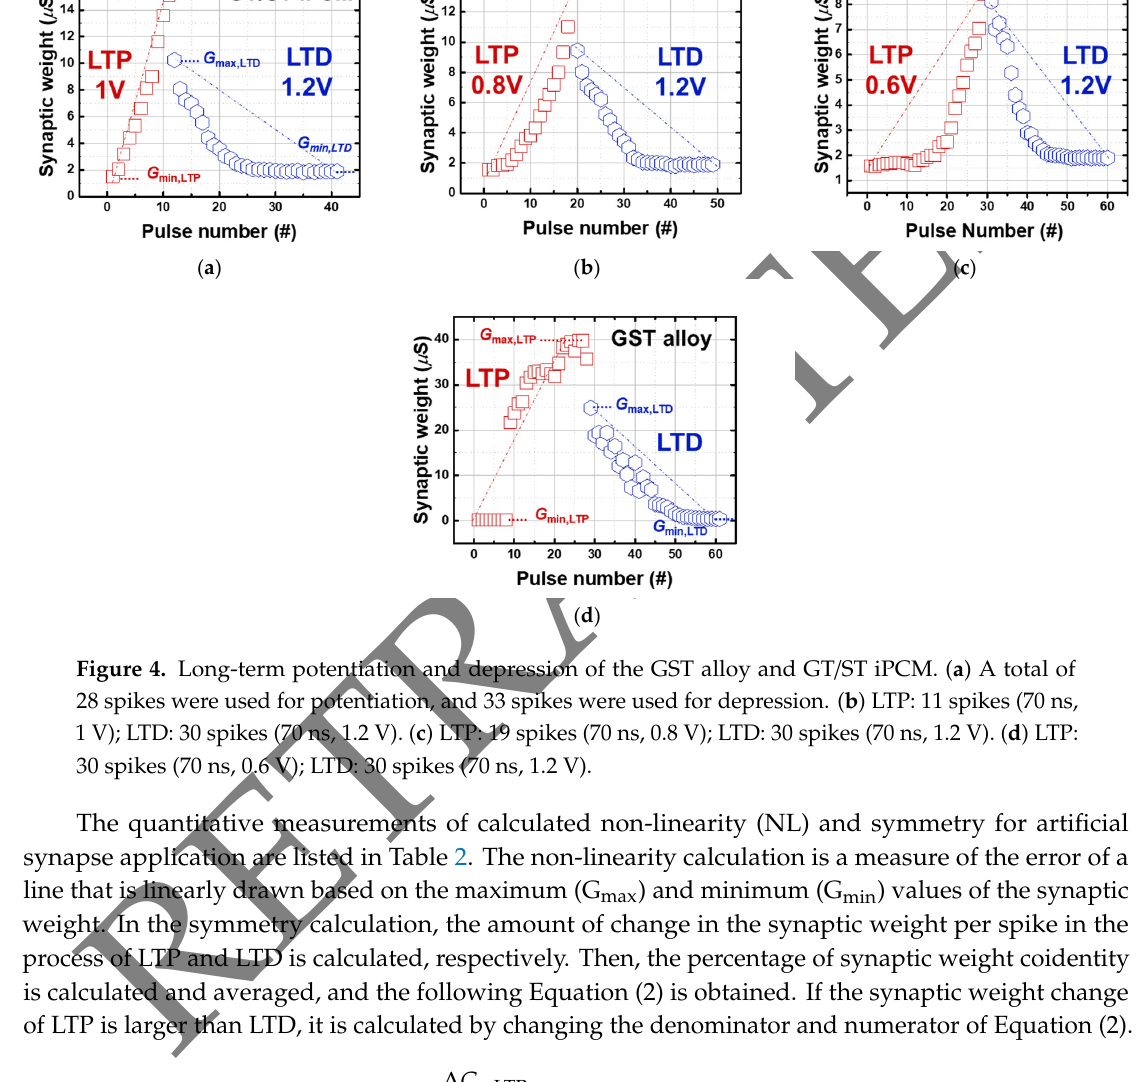
Table 2. Symmetry and non-linearity (NL) of the GST alloy and GT/ST iPCM samples.